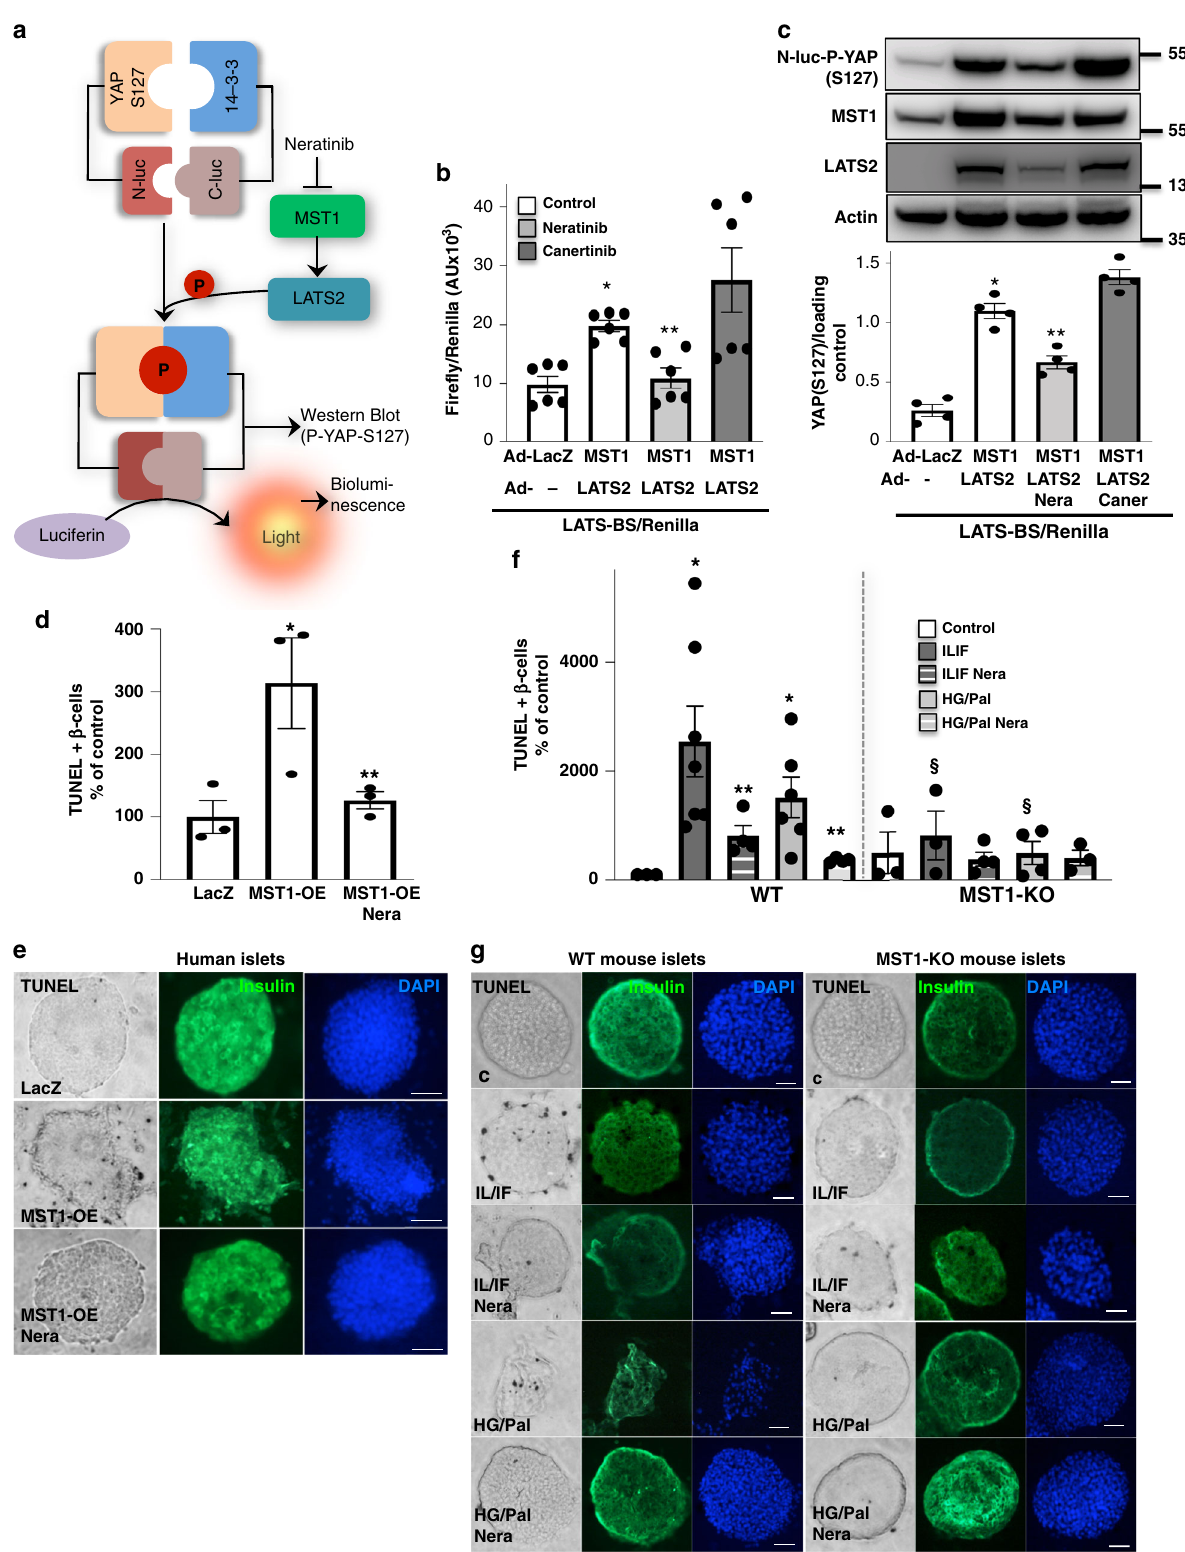
MST1 is the true target of neratinib in the context of β -cell protection from apoptosis, we evaluated its effect in isolated islets from global MST1-knockout (MST1-KO) mice and their wild- type (WT) littermates. While pro-in fl ammatory cytokines and glucolipotoxicity highly induced apoptosis in WT mice, their harmful effect on β -cell survival was almost gone in islets